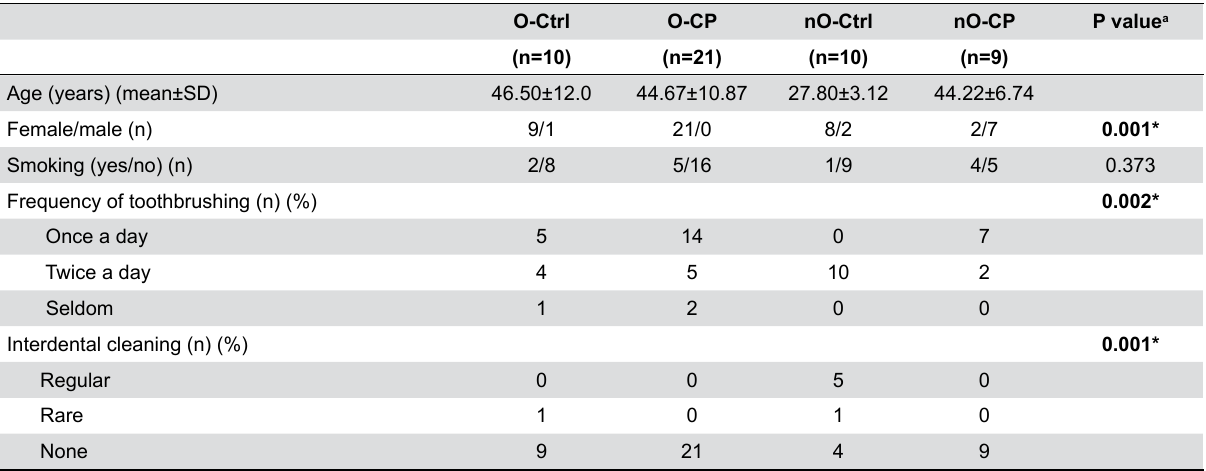
Table 3- Demographic characteristics of obese patients with chronic periodontitis (O-CP), obese individuals without chronic periodontitis (O-Ctrl), non-obese patients with chronic periodontitis (nO-CP) and non-obese individuals without chronic